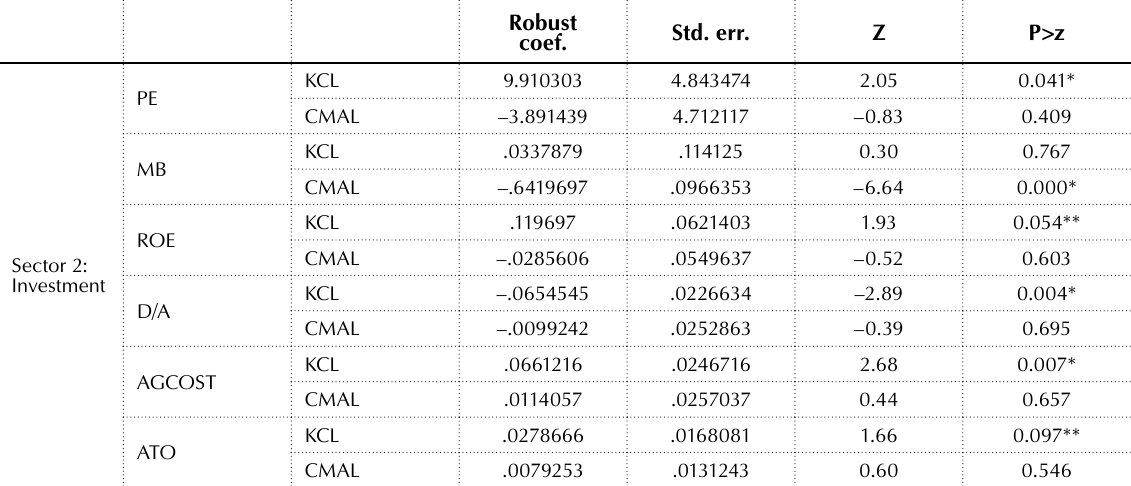
Table 8. GLS panel data regression for the investment sector